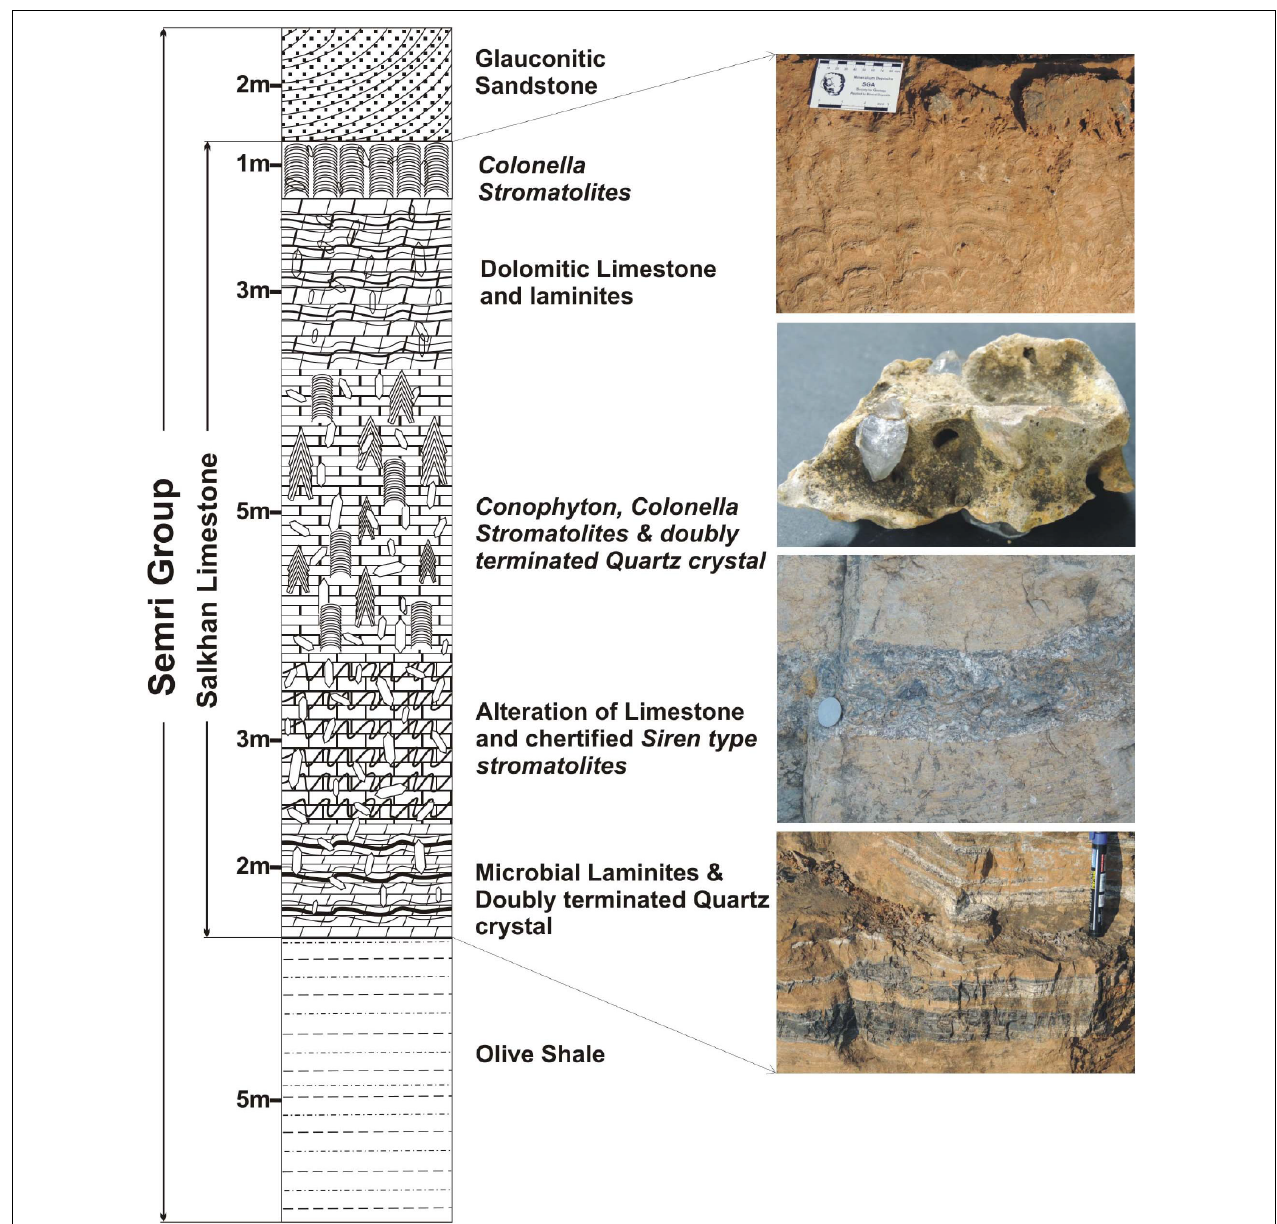
FIGURE 3 | Litho-column showing the Salkhan Limestone section exposed in the Newari in Sonbhadra district, Uttar Pradesh,